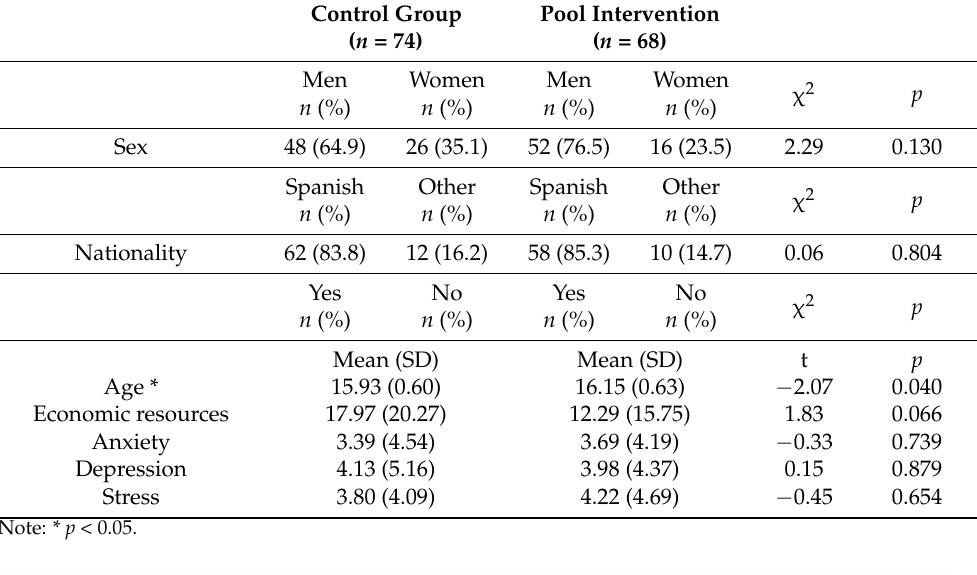
Table 2. Baseline sociodemographic and clinical characteristics of experimental and control groups in Time 1 (T1).